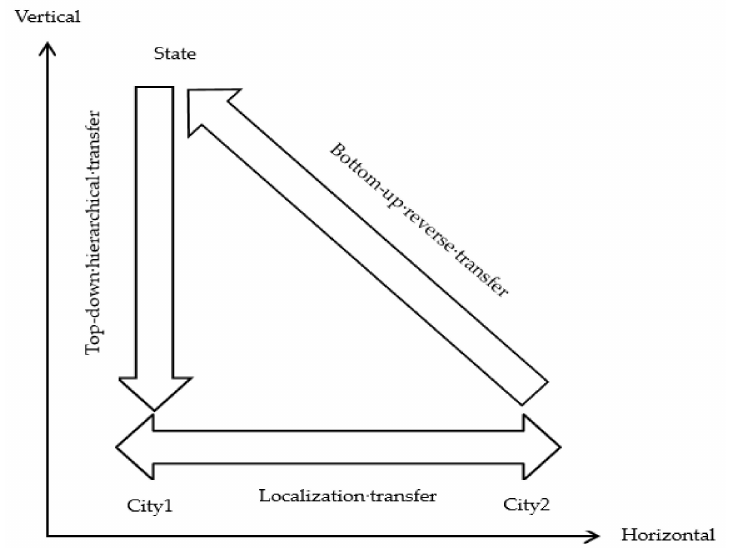
Figure 5. The spatial dimension of urban renewal policy transfer in